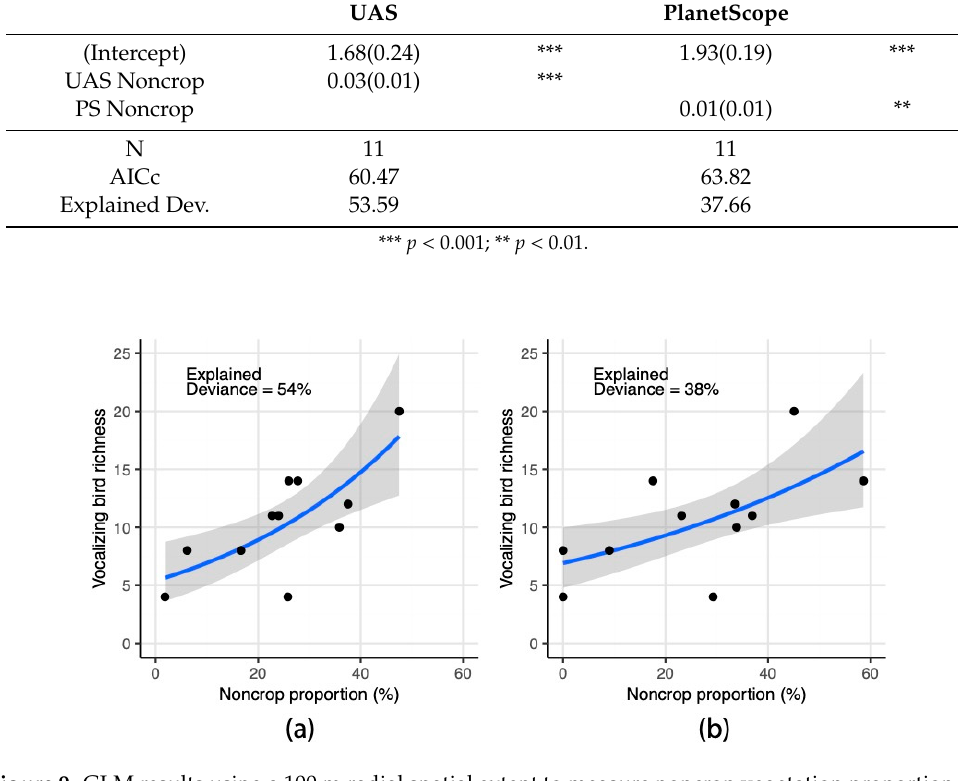
Figure 9. GLM results using a 100 m radial spatial extent to measure noncrop vegetation proportion for the UAS ( a ) and PlanetScope (PS) ( b ) data. The blue line indicates the fitted line, while gray shading indicates 95% confidence intervals.